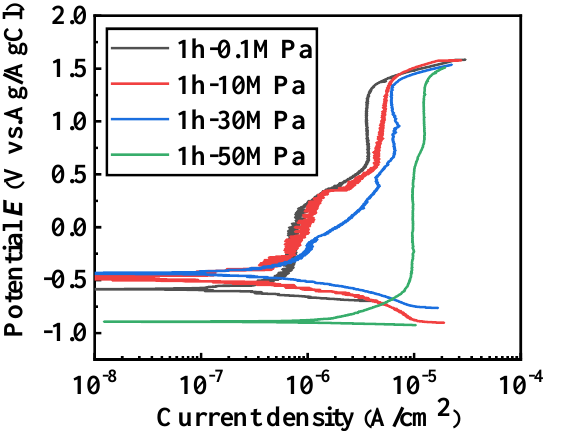
Figure 7. The polarization curves of TC4 alloy after 1 h charging in 3.5% NaCl solution at different HPs.